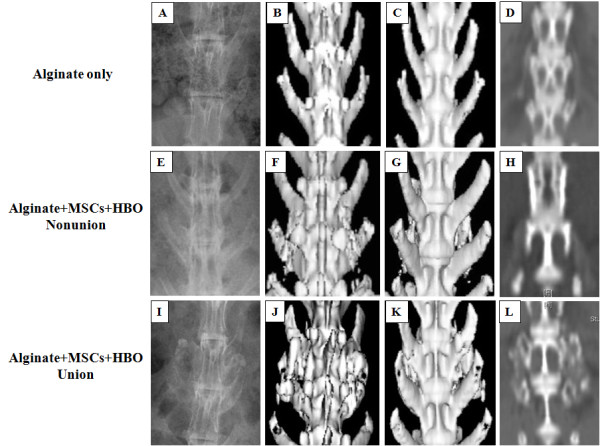
Results of plain radiographs (A, E, I), dorsal view (B, F, J) and ventral view (C, G, K) 3D CT scan images, and coronary reconstructive images (D, H, L) in groups of Alginate only and Alginate-MSCs under hyperbaric oxygen (HBO) treatment. A, B, C, D. The alginate carriers were completely absorbed and there was no bone formation between the transverse processes in the animal implanted with alginate without mesenchymal stem cells. E, F, G, H. Partial bone formation between the transverse processes in the animal implanted with Alginate-MSCs after HBO therapy. The scattered and uncalcified bone mass formation without successful fusion was noted. I, J, K, L. A successful, continuous bone fusion mass with calcification was noted between the transverse processes in the animal implanted with Alginate-MSCs after HBO therapy. No new bone formation occurred in any unintended areas on the CT scan images.